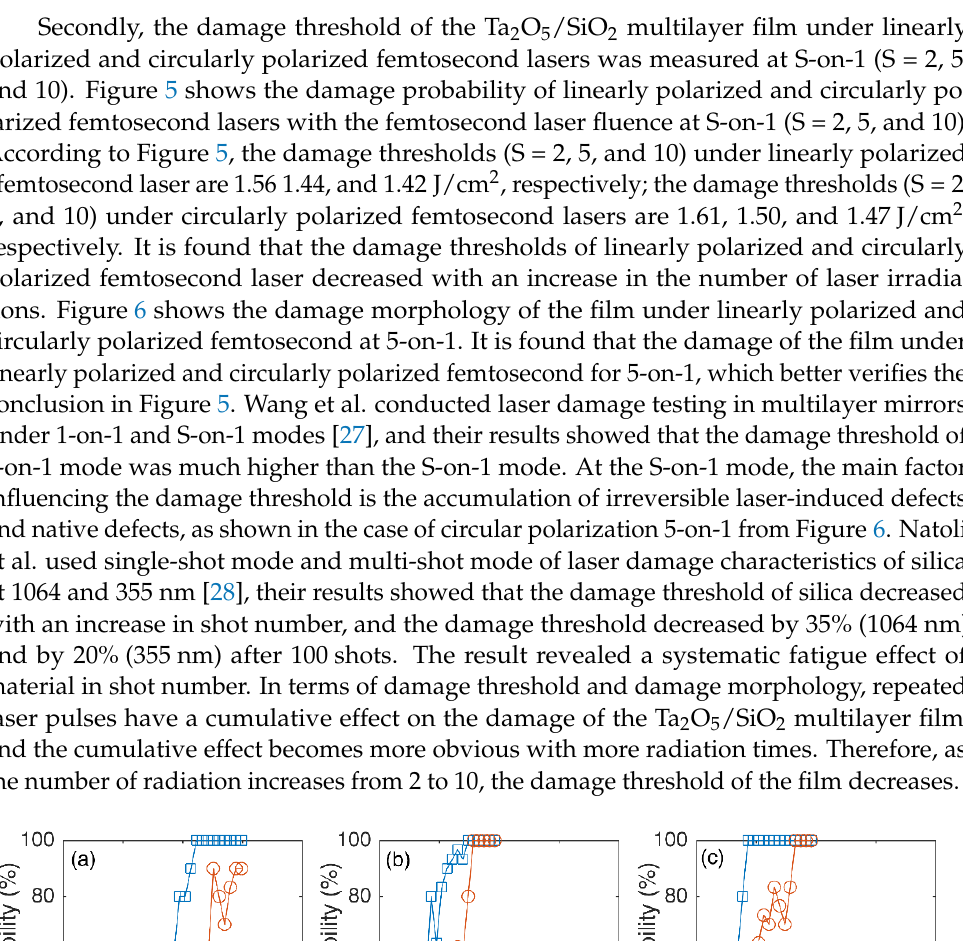
Figure 6. Damage morphology near damage threshold for linearly and circularly polarized lasers under 5-on-1. Note: black circle indicates some unapparent damage. 4. Conclusions The laser damage of the Ta 2 O 5 /SiO 2 multilayer film on the fused silica substrate prepared by electron beam evaporation was studied by 1-on-1 and S-on-1 measurements using linearly and circularly polarized femtosecond lasers. The damage threshold of the film under linear and circular polarization was obtained, and the damage morphology of the film under linear and circular polarization was observed by microscope. It was found that the damage threshold of linear polarization was lower than that of circular polarization, and the damage morphology of under polarization was more evident than that under linear polarization. The main reason was that the multi-photon ionization cross-section of linear polarization was higher than that of circular polarization, result- ing in a higher ionization rate of linear polarization. It was also found that the damage threshold of linearly polarized and circularly polarized femtosecond laser decreased with an increase in laser radiation number. The main reason was that repeated laser ra- diation had a cumulative effect on the film; the more repeated radiation, the more pro- nounced the cumulative effect. The result is of great significance for understanding the mechanism of femtosecond laser-induced optical film damage and the femtosecond laser projection of the film. Author Contributions: Conceptualization, L.Z., A.C. and C.Z.; methodology, L.Z., X.J., Y.W., Y.Z. A.C., J.S. and C.Z.; software, Y.W. and A.C.; validation, X.J., Y.W. and Y.Z.; writing — original draft preparation, L.Z., A.C. and C.Z.; writing — review and editing, L.Z., A.C. and C.Z.; project admin- istration, J.S.; funding acquisition, L.Z., J.S. and C.Z. All authors have read and agreed to the pub- lished version of the manuscript.